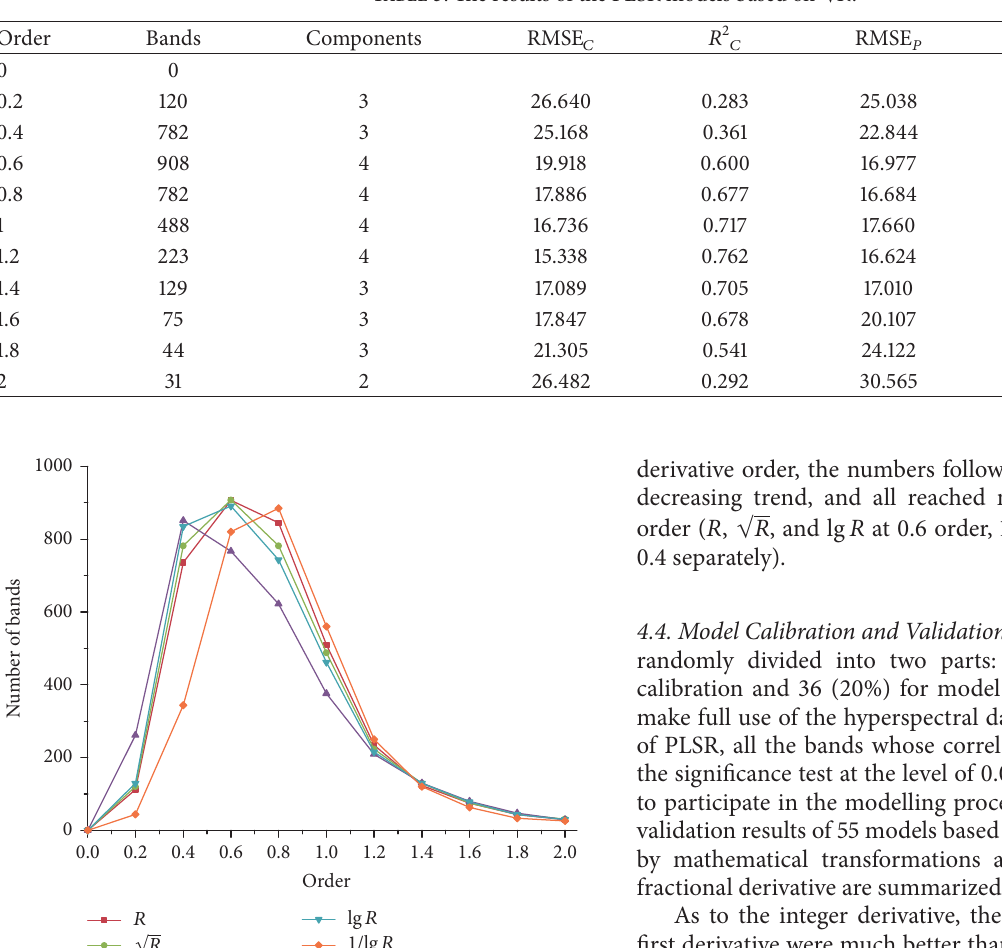
Table 3: The results of the PLSR models based on √𝑅 .